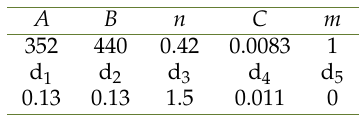
Fig. 1. Drilling geometry model. a) Tool geometry model